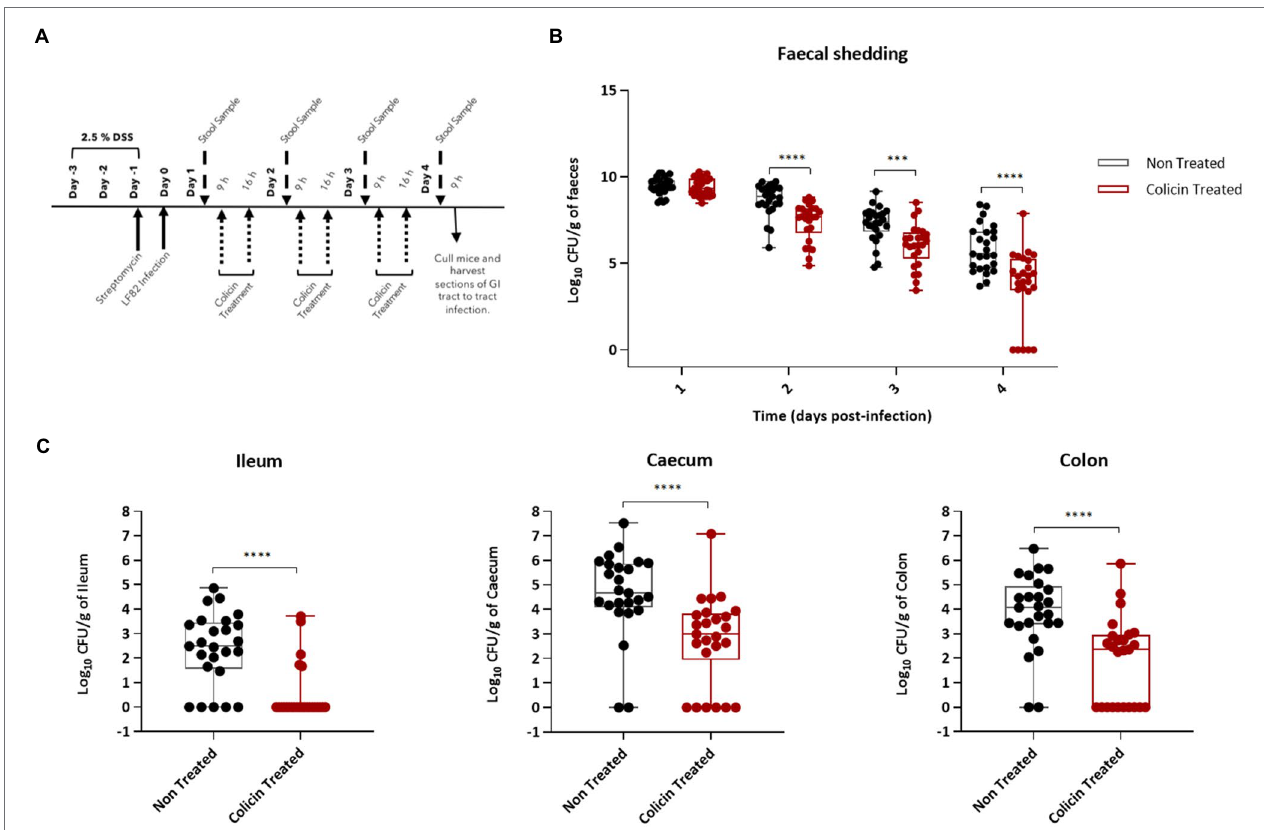
FIGURE 5 | Reduction in LF82 colonization of the lower gastrointestinal (GI) tract in infected mice treated with hydrogel-encapsulated colicins. An E. coli LF82 murine infection model was used to assess the efficacy of the hydrogel encapsulated treatment using a combination of E9 and Ia. Day one post-bacterial challenge, mice were treated by oral administration of 200 μ l of colicin E9 and Ia (dose of 0.5 mg each of E9 and Ia) containing hydrogel in a slurry with PBS or 200 μ l of colicin free hydrogel slurry (control group). (A) Experimental scheme. (B) Tukey boxplot of fecal shedding of E. coli LF82StrpR. (C) Levels of LF82StrpR strain in both control (black, n = 25) and colicin treated (red, n = 25) groups for the different sections of the GI tract. Statistical analysis was carried out for each subset using a Mann–Whitney test between LF82StrpR infected and colicin-treated groups. *** p < 0.0004, **** p <